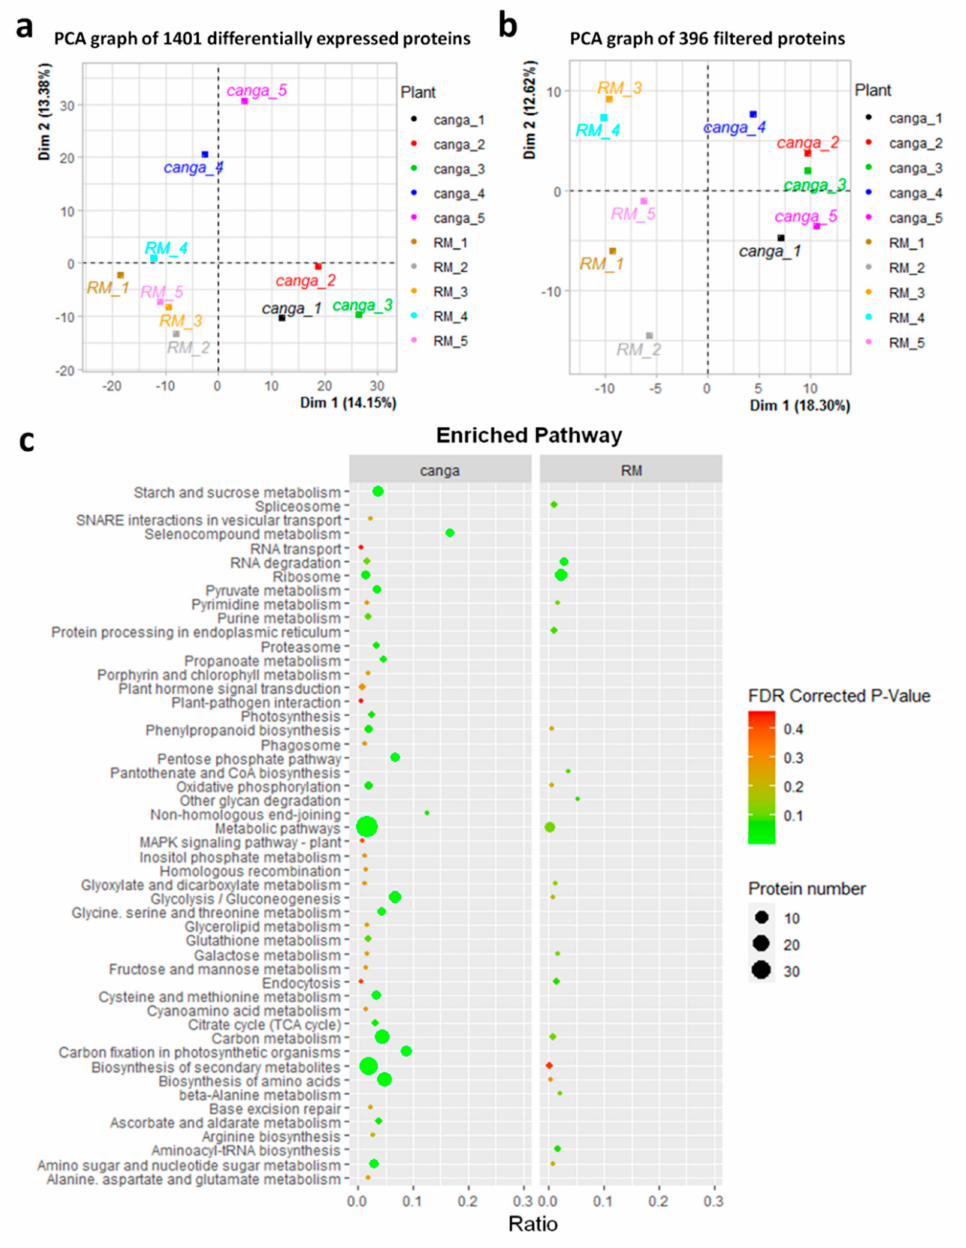
Figure 1. PCA and enrichment analysis of the proteins with differential abundances in D. apurensis roots sampled from canga ( canga ) or in rehabilitating mineland (RM). ( a ) PCA of 1401 differentially accumulated proteins comparing five plants from canga with five from RM. ( b ) PCA of differentially accumulated and filtered proteins based on p < 0.05 and fold change ≥ 1.5. ( c ) Enrichment analysis of the most accumulated proteins in different biological processes. The significantly enriched KEGG pathways were indicated as dots (FDR corrected p < 0.05, Fisher’s exact test, Benjamini and Hochberg FDR correction method). The dot sizes represent the number of proteins included in each pathway. The x-axis represents the ratio of the number of differentially accumulated proteins and the number of all proteins in the